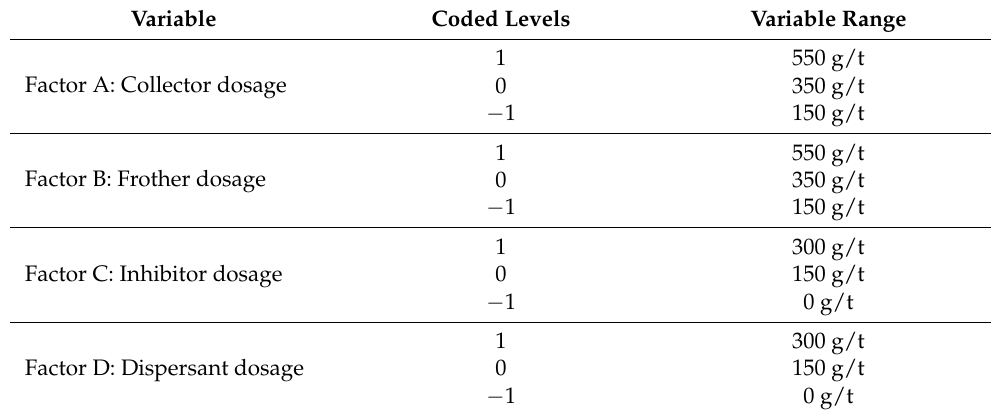
Table 2. Variables for the full factorial design. “1” corresponds to a high factor level; “−1“refers to a low factor level; “0” refers to a center point.